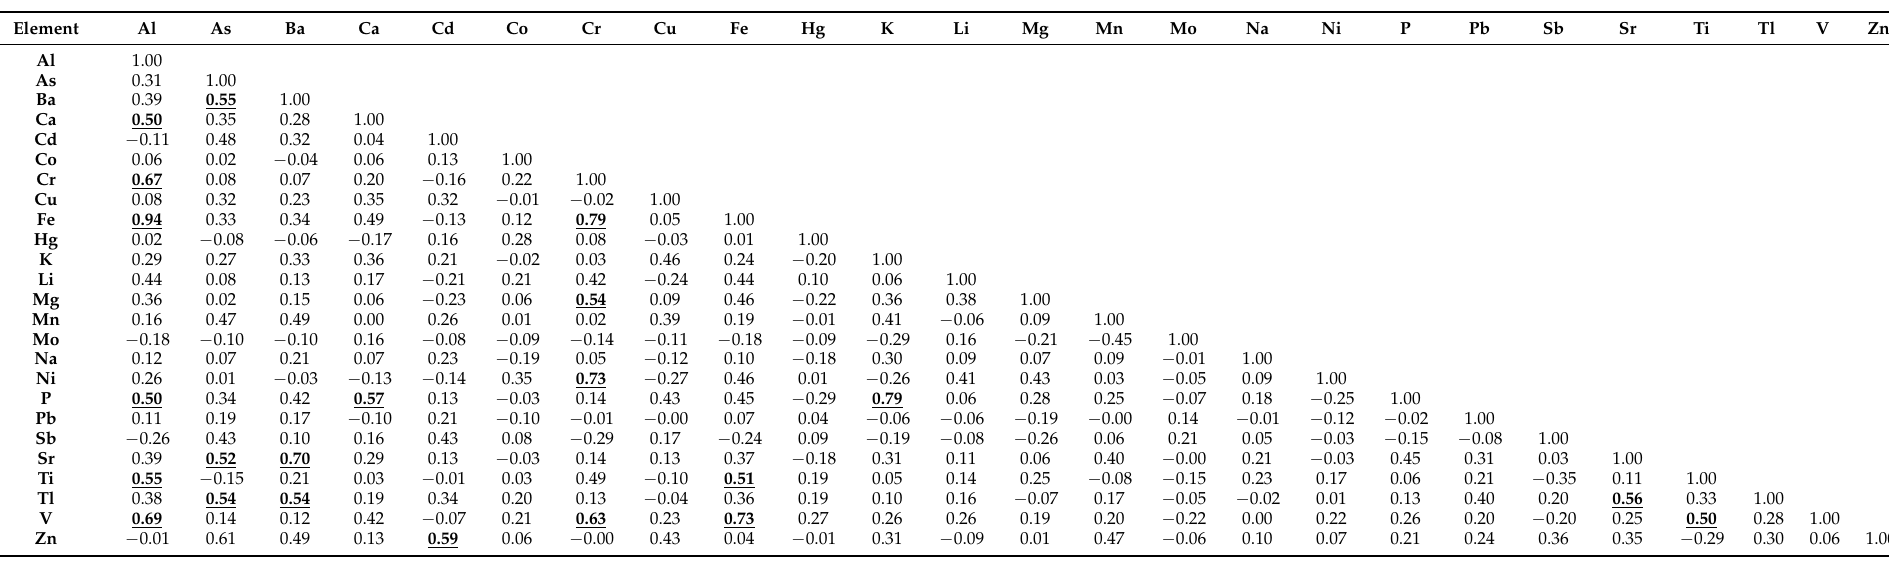
Table 3. Pearson correlation coefficient (r) between elements content in mosses in Kosovo ( n = 45, 25 elements naturally and anthropogenically distributed)